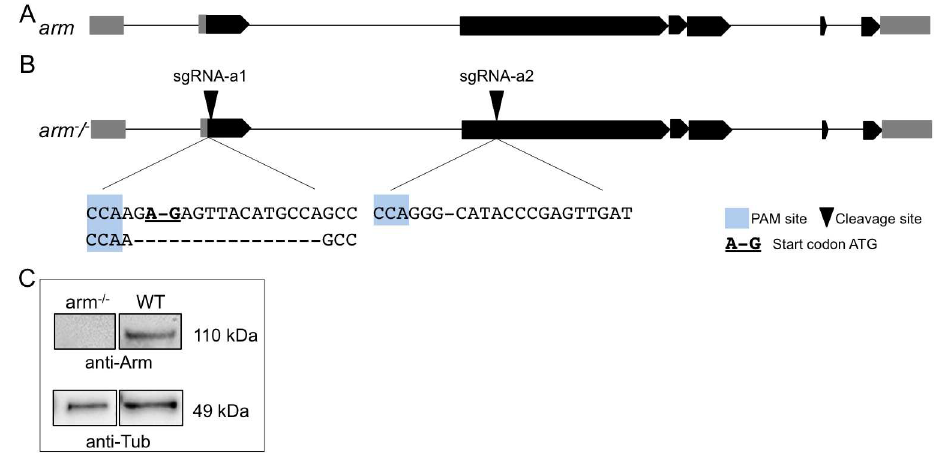
Fig 2. Mutagenesis of the arm gene. (A) Schematic of the arm gene-locus. Untranslated regions (UTR) are indicatedin grey boxes, translated exons in black. (B) CRISPR targeting strategy: Target sites of both sgRNAs are representedby black triangles. The PAM site is highlighted in blue. Sequencesas they are present in arm -/–AFII7/8 (arm -/- ) cells are depictedbelow. Bold and underlinednucleotides represent the TSS. (C) Western blot analysisusing an α -Arm antibodyon lysates from wild-type(WT) and arm -/–AFII7/8 (arm -/- ) cells. As expectedthe arm -/–AFII7/8 (arm -/- ) cells are devoidof Arm protein. Tubulinwas used as loading